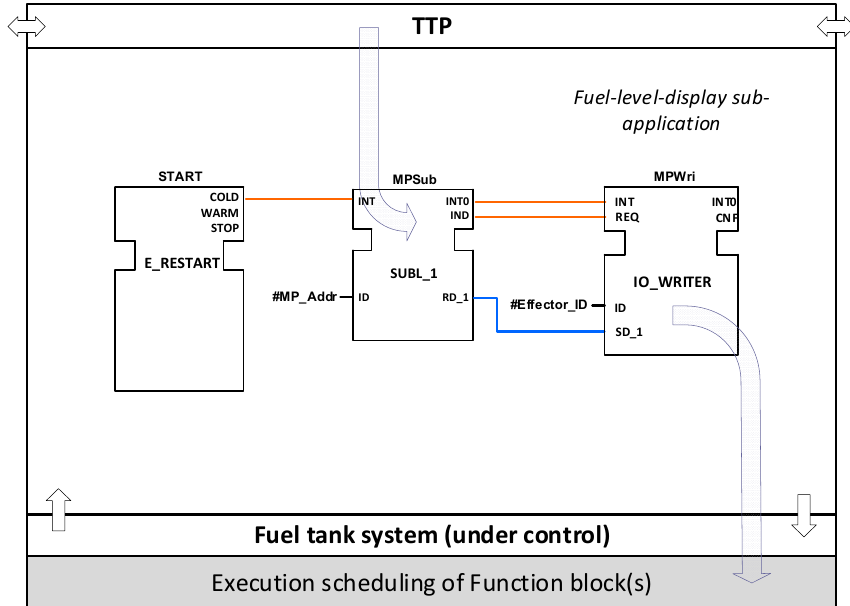
Figure 13. Configuration of resource I.A from CPIOM-Control device for scenario 1 and resource III.A from CPIOM-Control device for scenario 2.